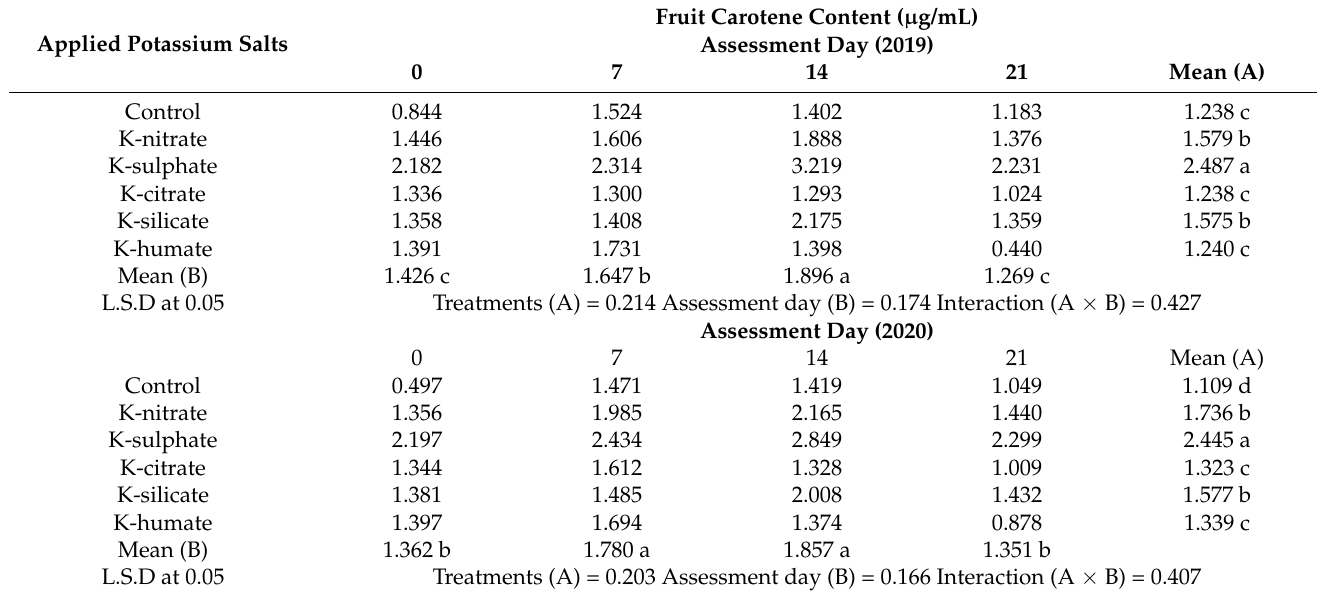
Table 5. Effect of diverse potassium forms as foliar application on carotene content ( µ g/mL) of apricot fruits cv. ‘Canino’ in 2019 and 2020 seasons during cold storage 0 ± 1 ◦ C and 90 ± 5% RH.